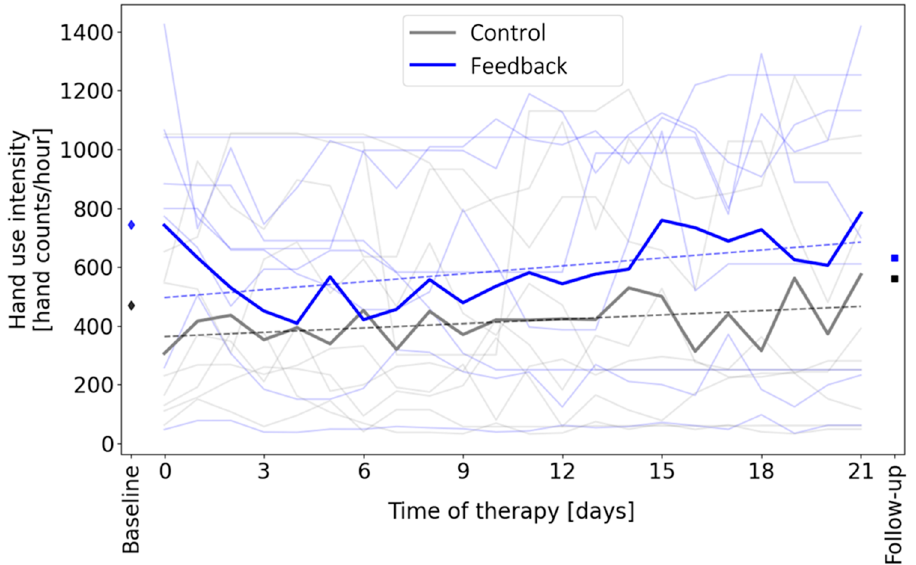
Figure 6. Effect of feedback on hand use intensity. The light lines show data from individuals in order to show variability within and across participants. The dark lines show the group averages. The feedback group significantly increased their hand count intensity over time (dashed line, linear regression, p = 0.012, slope = 9.0 hand counts/hour per day, which amounted to ~2000 additional counts per day by study end), while the control group did not ( p = 0.059; slope = 4.87 hand counts/hour per day). The diamonds and squares show the hand use intensity measured at baseline and follow-up, respectively, when the feedback screen was turned off for all participants. Hand use intensity was not significantly different between groups on the baseline or follow-up days ( t -test, p > 0.05).